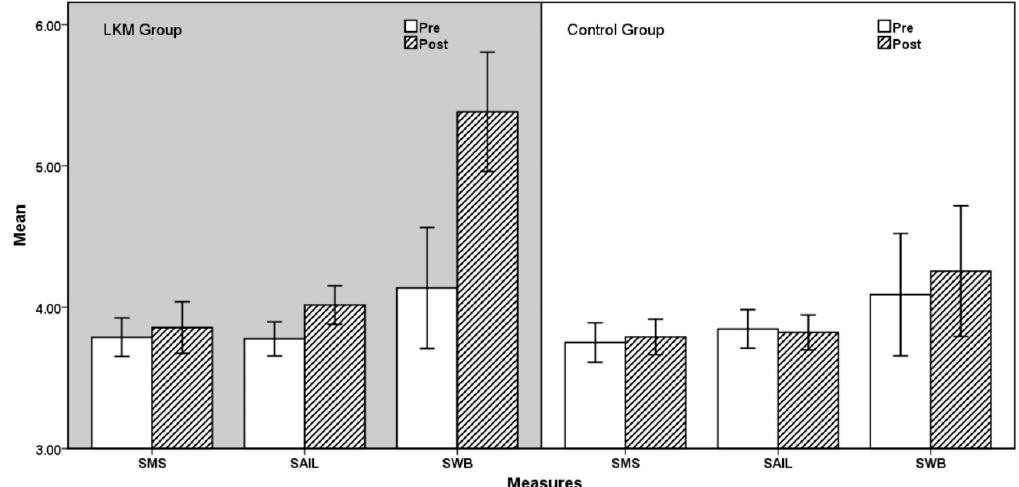
Figure 2. Comparison of three measures between LKM and Control Group. SMS, State Mindfulness Scale; SAIL, Spiritual Attitude and Involvement List; SWB, Subjective Well-Being.